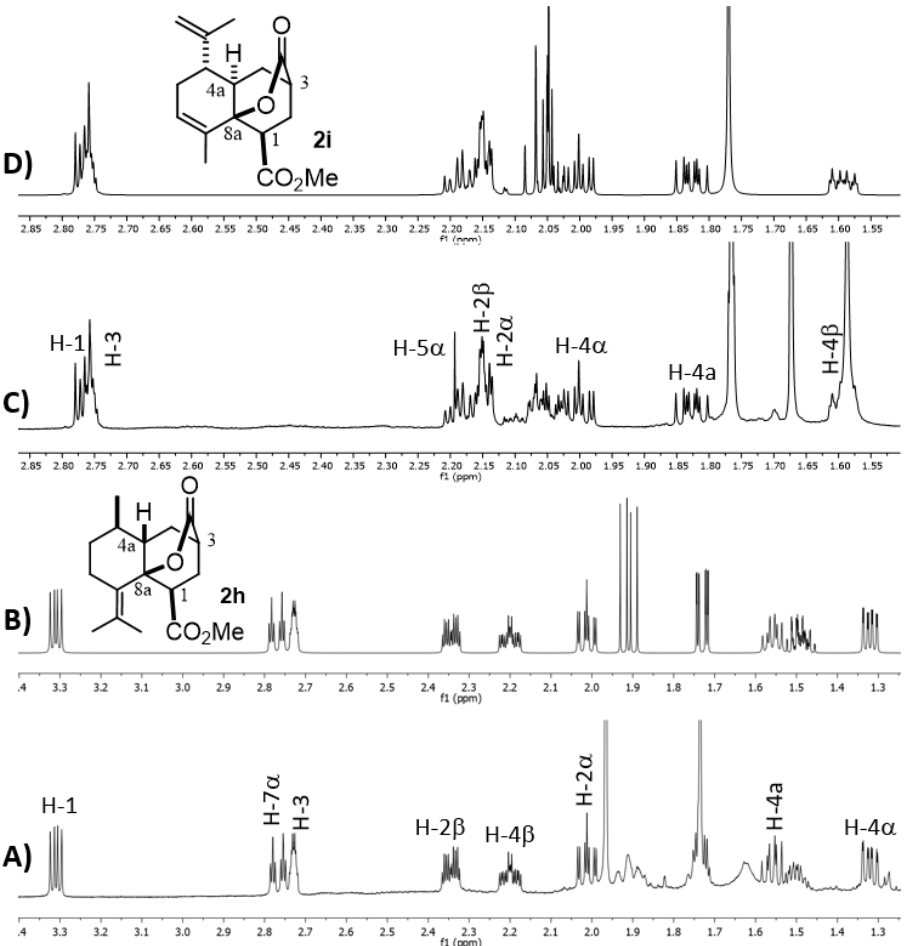
Figure 6. Experimental ( A , C ) and simulated ( B , D ) 1 H NMR spectra of 2h and 2i , respectively. Full 1 H NMR simulated parameters were considered only for shown protons.